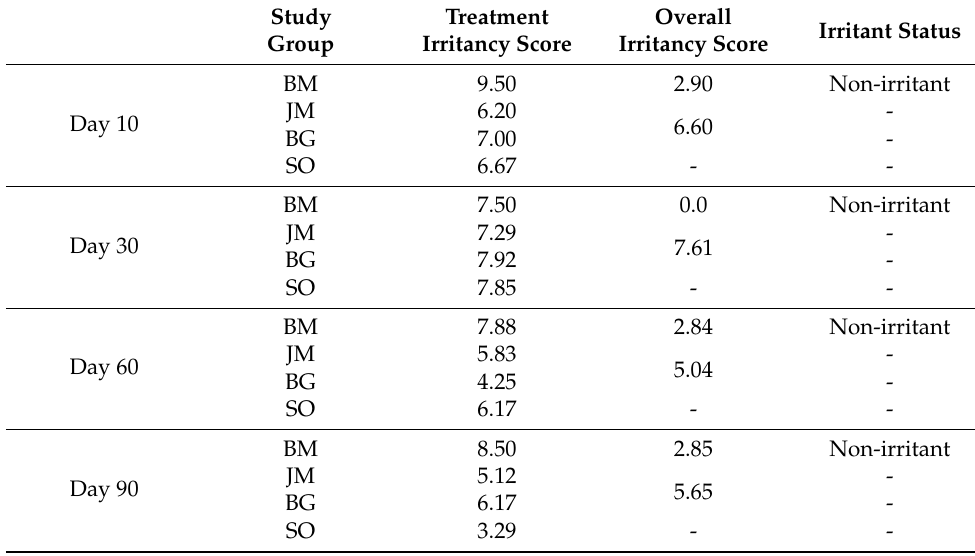
Table 8. Irritancy scores and irritancy status of the bovine-derived membrane at 10-, 30-, 60-, and 90-days post